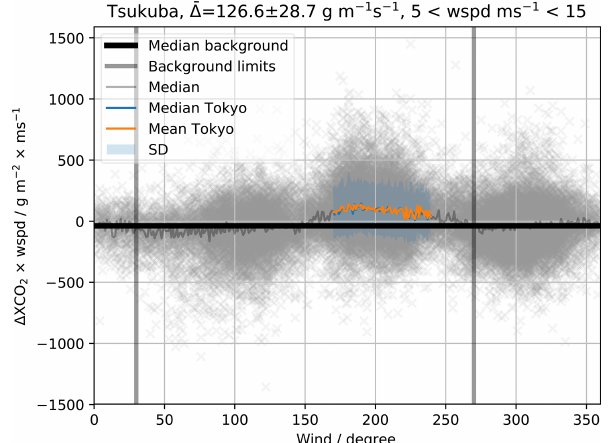
Figure 5. Residuals multiplied by wind speed plotted against the wind direction for scaled wind speeds between 5 and 15ms − 1 , measured by the TCCON site in Tsukuba, Japan. The mean en- hancement (cid:49) , the mean Tokyo and median Tokyo values and the standard deviation are calculated for the directions defined as from Tokyo in Fig. 3. The median background is calculated from the residuals outside the background limits (lower than 30 ◦ or higher than 270 ◦ ; limits drawn as vertical lines). The bin size is 1 ◦ .